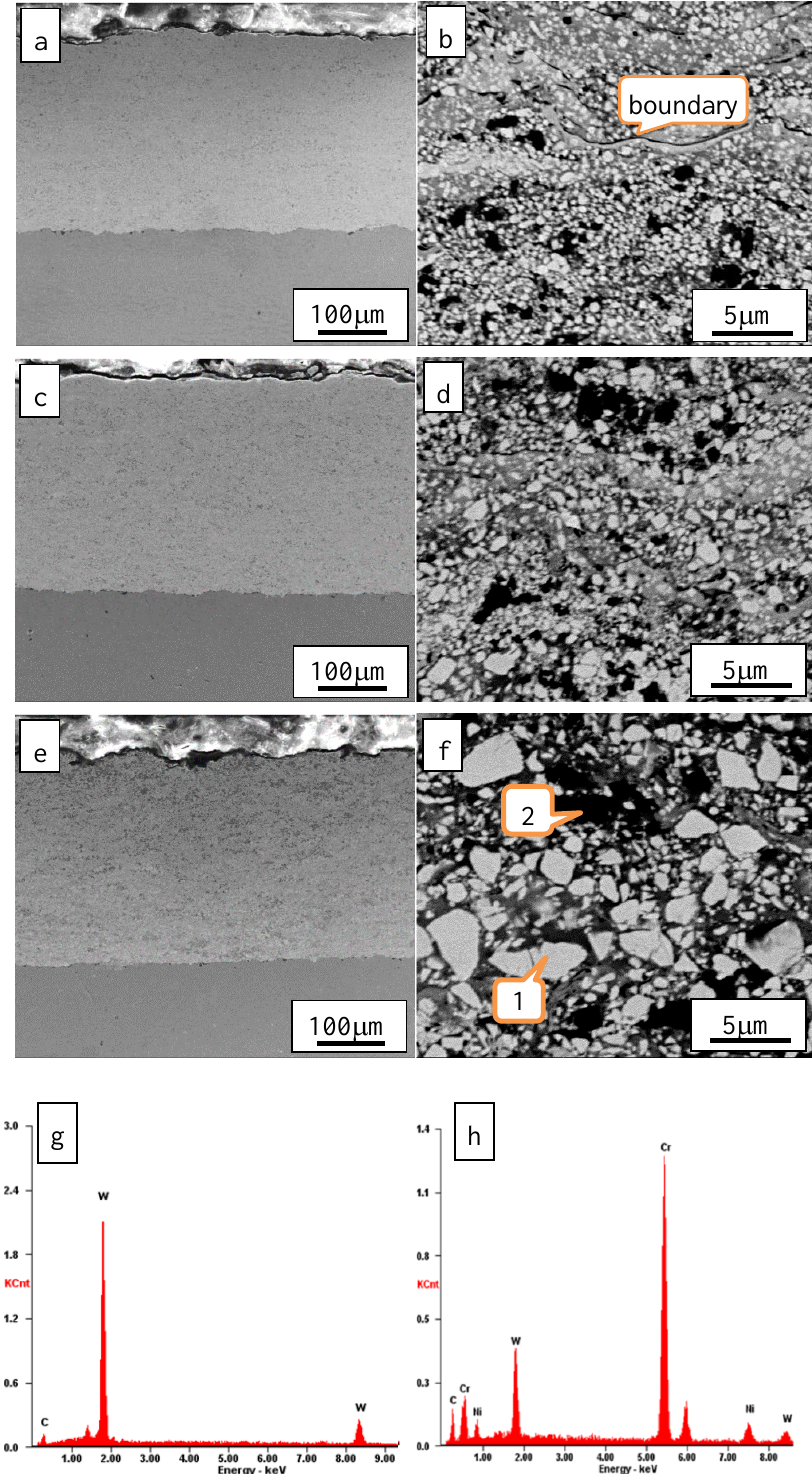
Figure 6. Cross-sectional microstructures of the ( a , b ) FC, ( c , d ) MC, and ( e , f ) CC coatings, ( g , h ) EDS results of the “1” and “2” marked in ( f ).